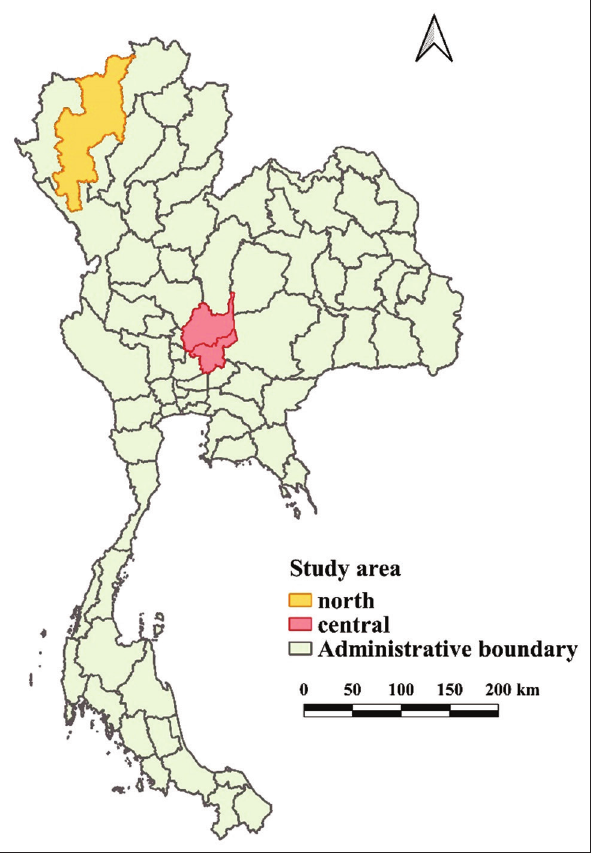
Figure-1: A map depicting the study provinces in the northern and central regions of Thailand. Milk samples were collected from dairy farms located in these provinces. The map was created using QGIS (version 2.18.28), QGIS Geographic Information System, Open Source Geospatial Foundation Project. All content is licensed under Creative Commons Attribution ShareAlike 3.0 license (CC BY-SA), available at